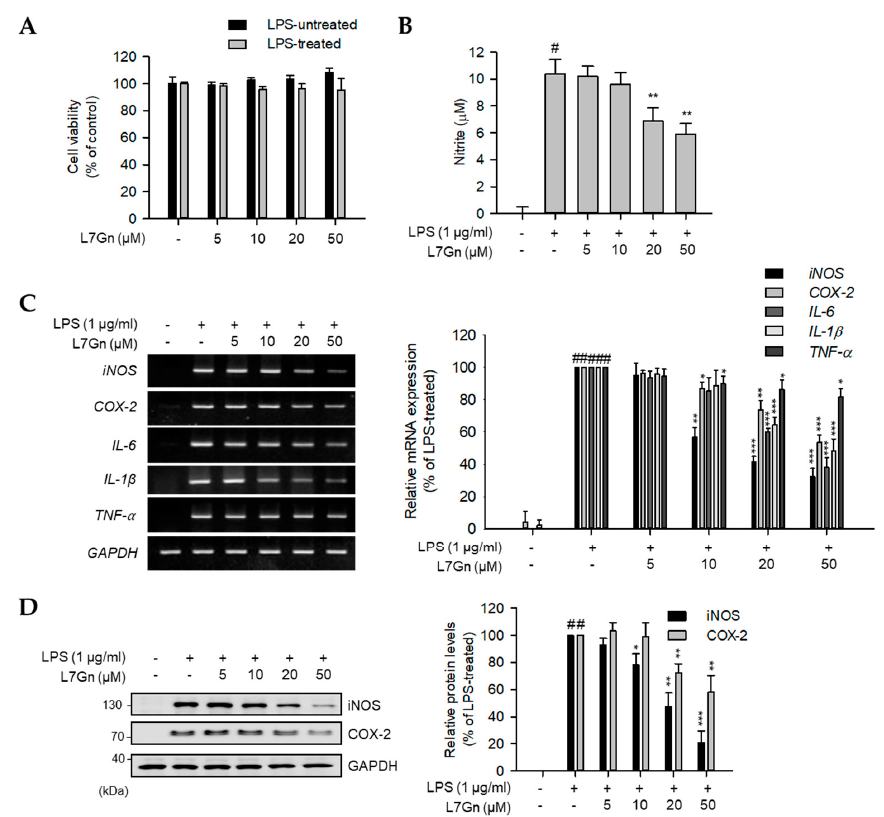
Figure 2. Inhibitory effects of L7Gn on the production of proinflammatory mediators. ( A and B ) RAW 264.7 macrophages were pre-treated with various concentrations of L7Gn (0, 5, 10, 20, and 50 µM) for 2 h, and incubated in the presence or absence of lipopolysaccharide (LPS) (1 µg/mL) for an additional 24 h. ( A ) Cell viability was examined using EZ-Cytox assay solution and results were expressed relative to those for the untreated control group. Data represent the mean ± standard deviation (S.D.). ( B ) Nitric oxide (NO) secretion levels in culture media measured using Griess reagent. NO levels were calculated according to a standard curve plotted using a nitrite standard solution. Data represent the mean ± S.D. ( C and D ) RAW 264.7 cells were pre-treated with L7Gn (0, 5, 10, 20, and 50 µM) for 2 h and then incubated with LPS (1 µg/mL) for indicated times (3 h for RT-PCR and 24 h for immunoblotting analyses). ( C ) Total RNA was extracted and reverse transcribed to cDNA. Inducible NO synthase ( iNOS ), cyclooxygenase-2 ( COX-2 ), and pro-inflammatory cytokines were amplified by PCR and detected on agarose gel. The representative data are shown. ( D ) Total cell lysates were prepared and immunoblot analysis was performed. The protein expression of iNOS and COX-2 was detected using an ECL system and quantified using the LabWorks software. Expression levels of iNOS and COX-2 proteins were normalized to that of GAPDH. Relative expression levels of iNOS and COX-2 are represented as a bar graph (lower panel). Data represent the mean ± S.D. # p < 0.01 relative to the LPS-treated and L7Gn-untreated control group. * p < 0.05, ** p < 0.01, and *** p < 0.001 relative to the LPS-treated and 5 µM L7Gn-treated group.